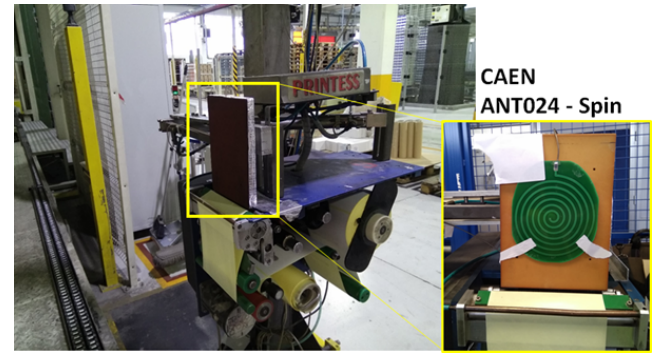
Figure 4. RFID label printer at the end of the production